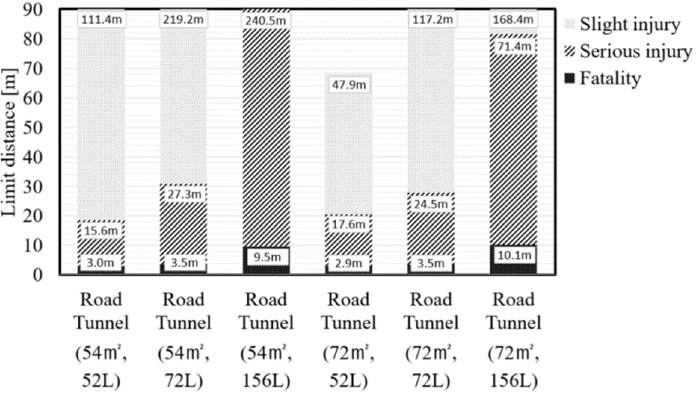
Figure 18. Limit distances in the road tunnel according to cross-sectional area and tank capacity.